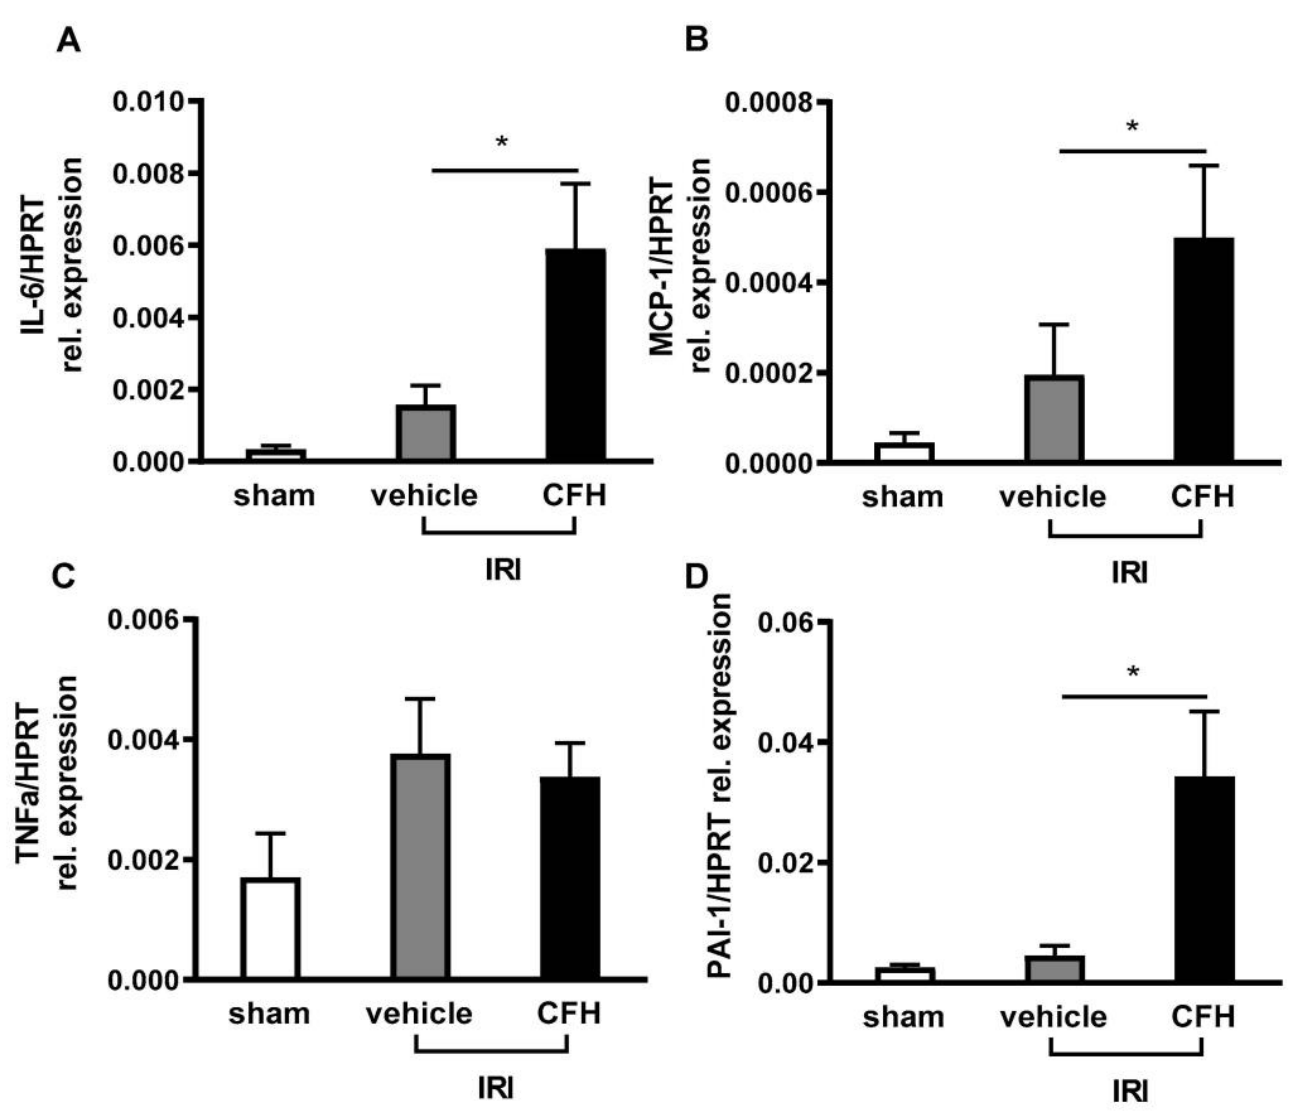
Figure 4. mRNA expressions of the proinflammatory cytokines IL-6 ( A ), MCP-1 ( B ), TNF α ( C ), and the profibrotic cytokine PAI-1 ( D ) in mice kidney tissue were analyzed 48 h after sham (white bar), IRI and vehicle (grey bar) and IRI + CFH administration (black bar). Renal RI with an ischemia time of 15 min did not cause significant renal upregulation of proinflammatory or profibrotic cytokines. In contrast, mice exposed to CFH after IRI exhibited enhanced renal expression of IL-6, MCP-1, and PAI-1. * p < 0.05.